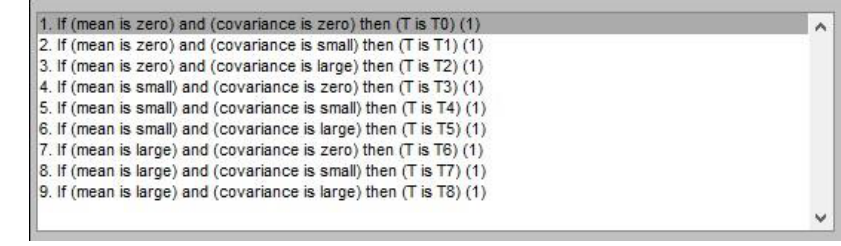
Figure 3. Fuzzy rules.